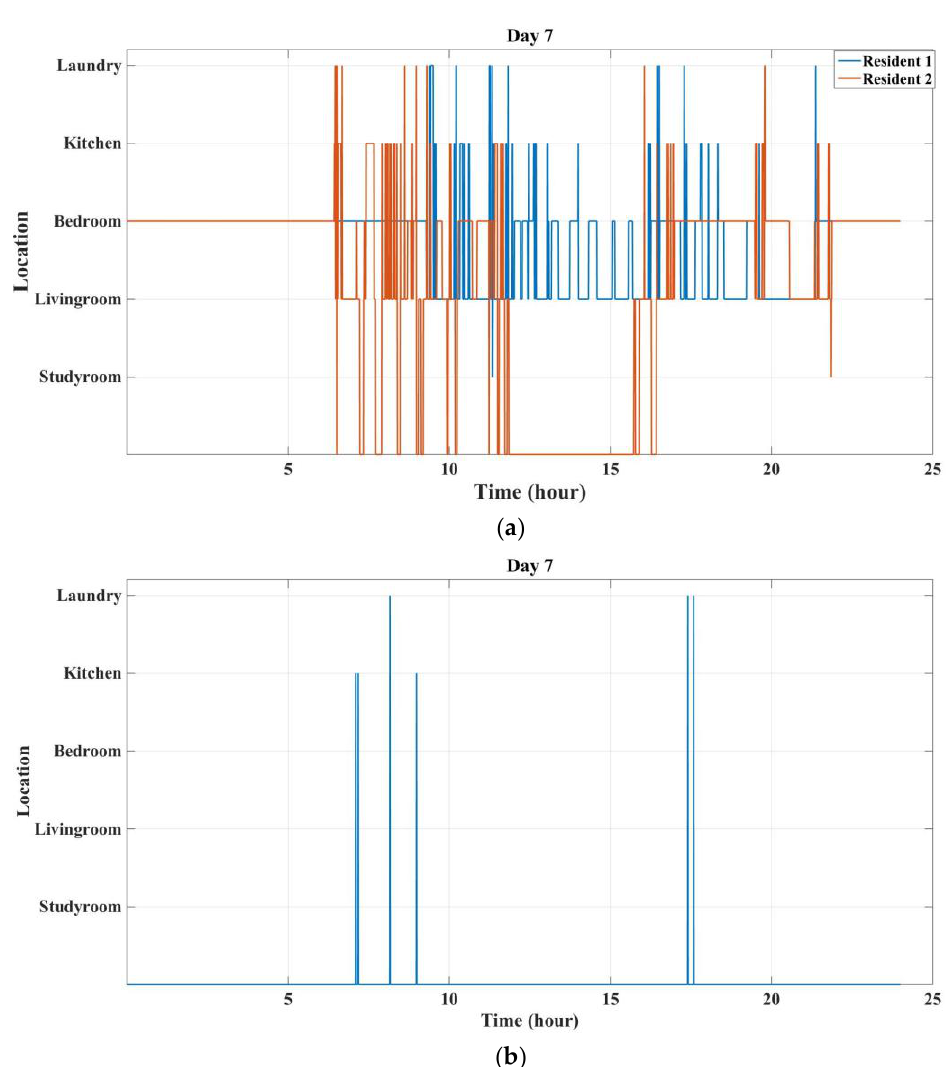
Figure 12. Localization and activity labelling results for the seventh day: ( a ) Resident localization results; ( b ) Non-labelled sensor events.